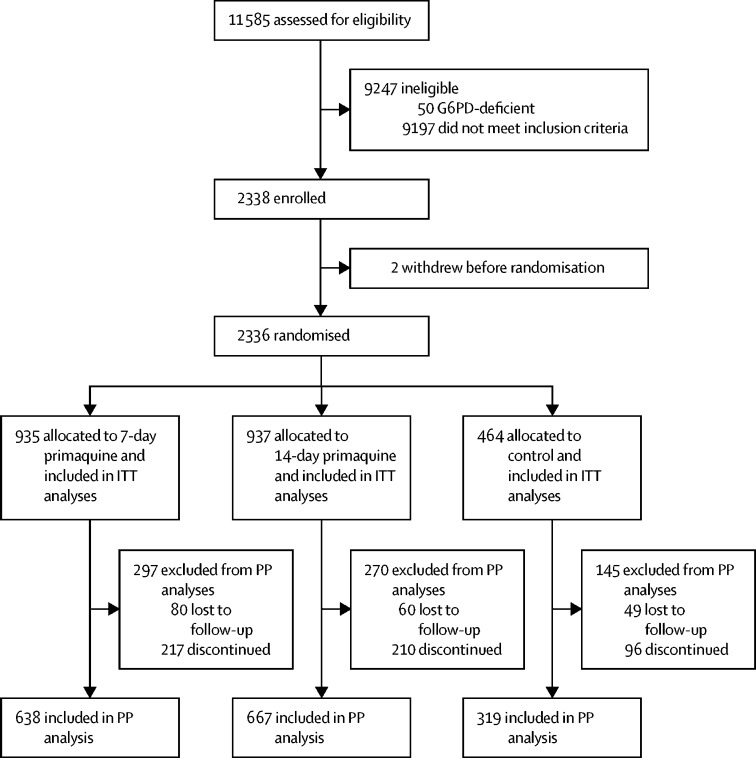
Trial profileG6PD=glucose-6-phosphate dehydrogenase. ITT=intention-to-treat. PP=per-protocol.